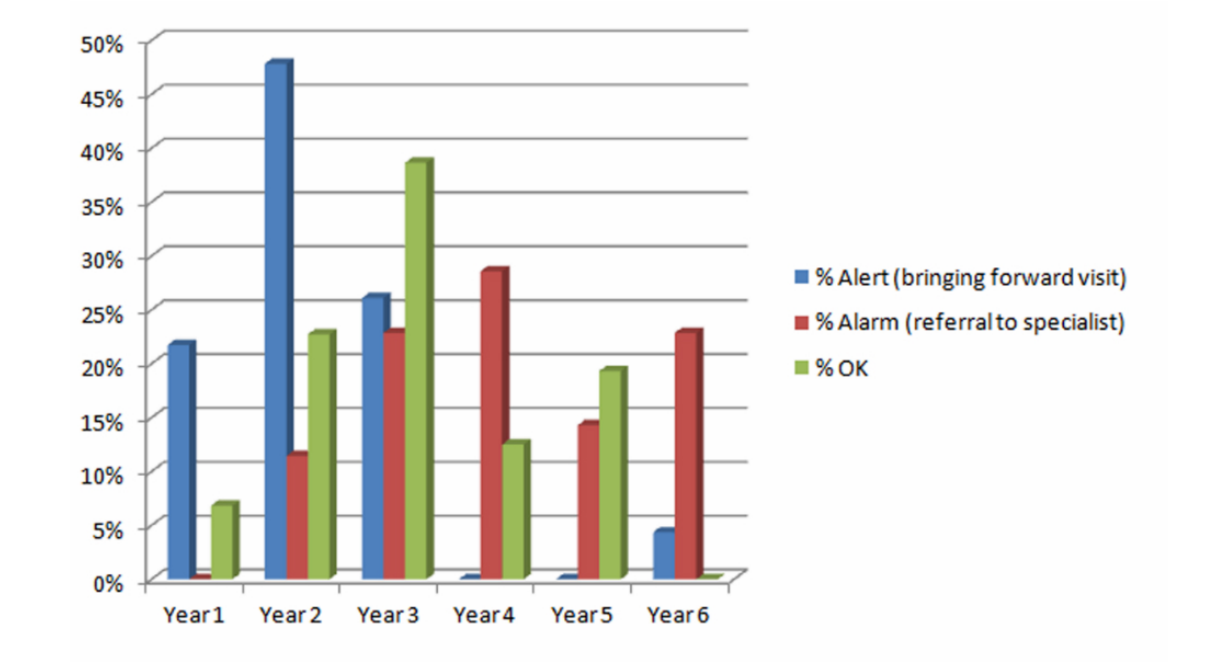
Figure 6. Evaluations percentage by result and